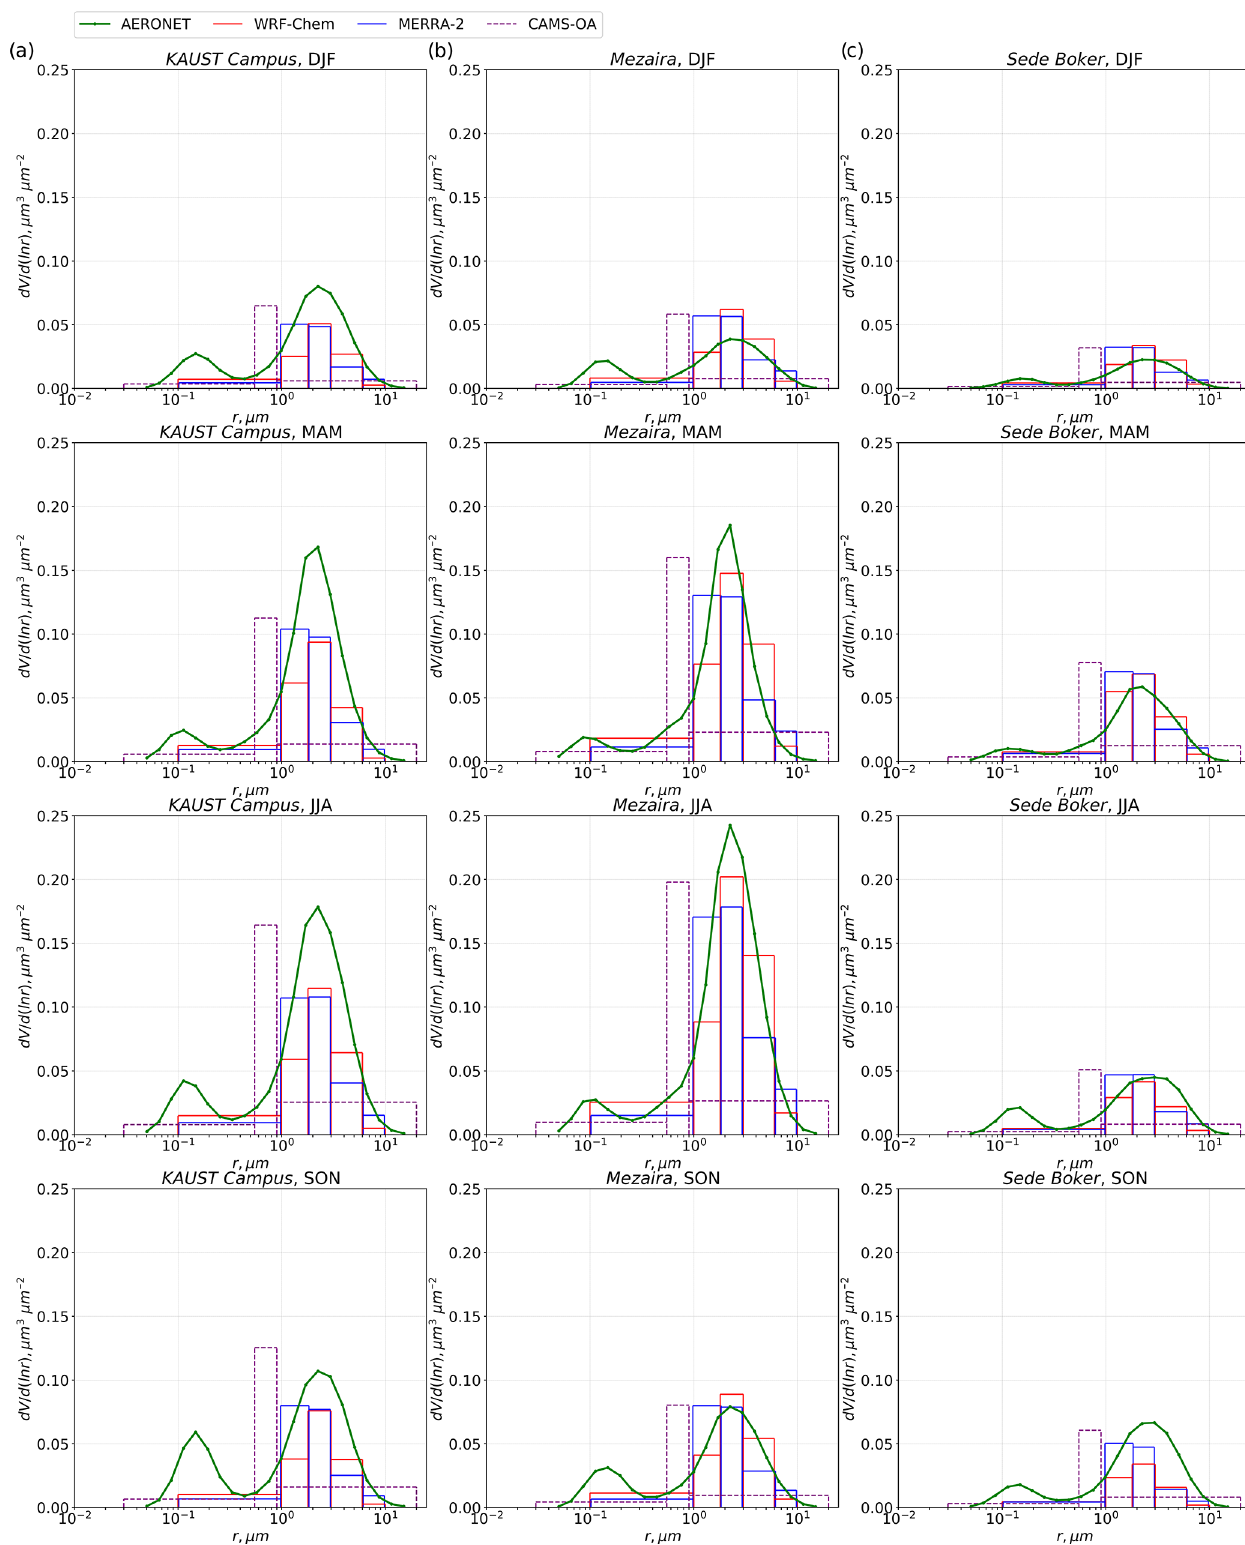
Figure 4. Seasonally averaged 2015–2016 AVSDs (µm 3 µm − 2 ) obtained from MERRA-2, CAMS-OA, WRF-Chem, and the AERONET inversion algorithm at the (a) KAUST Campus, (b) Mezaira, and (c) Sede Boker AERONET sites. Winter (DJF), spring (MAM), summer (JJA), and autumn